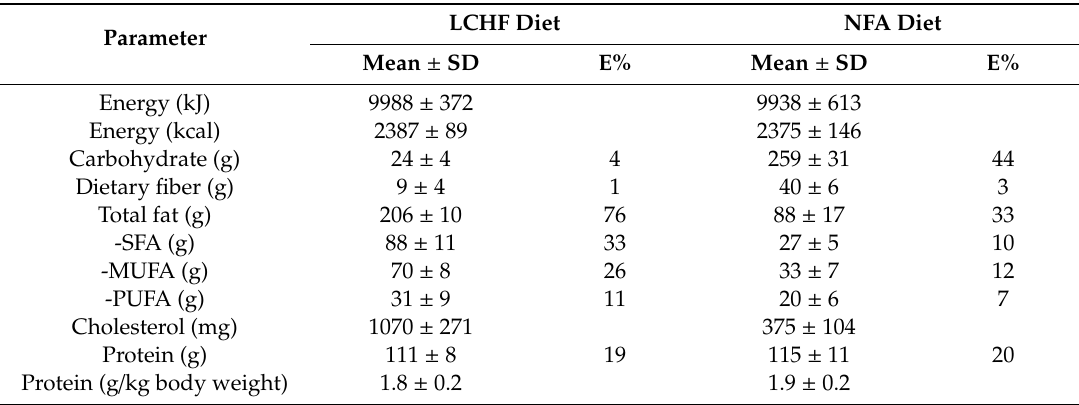
Table 2. Mean daily energy and nutrient intake during 28 days of feeding trial 1